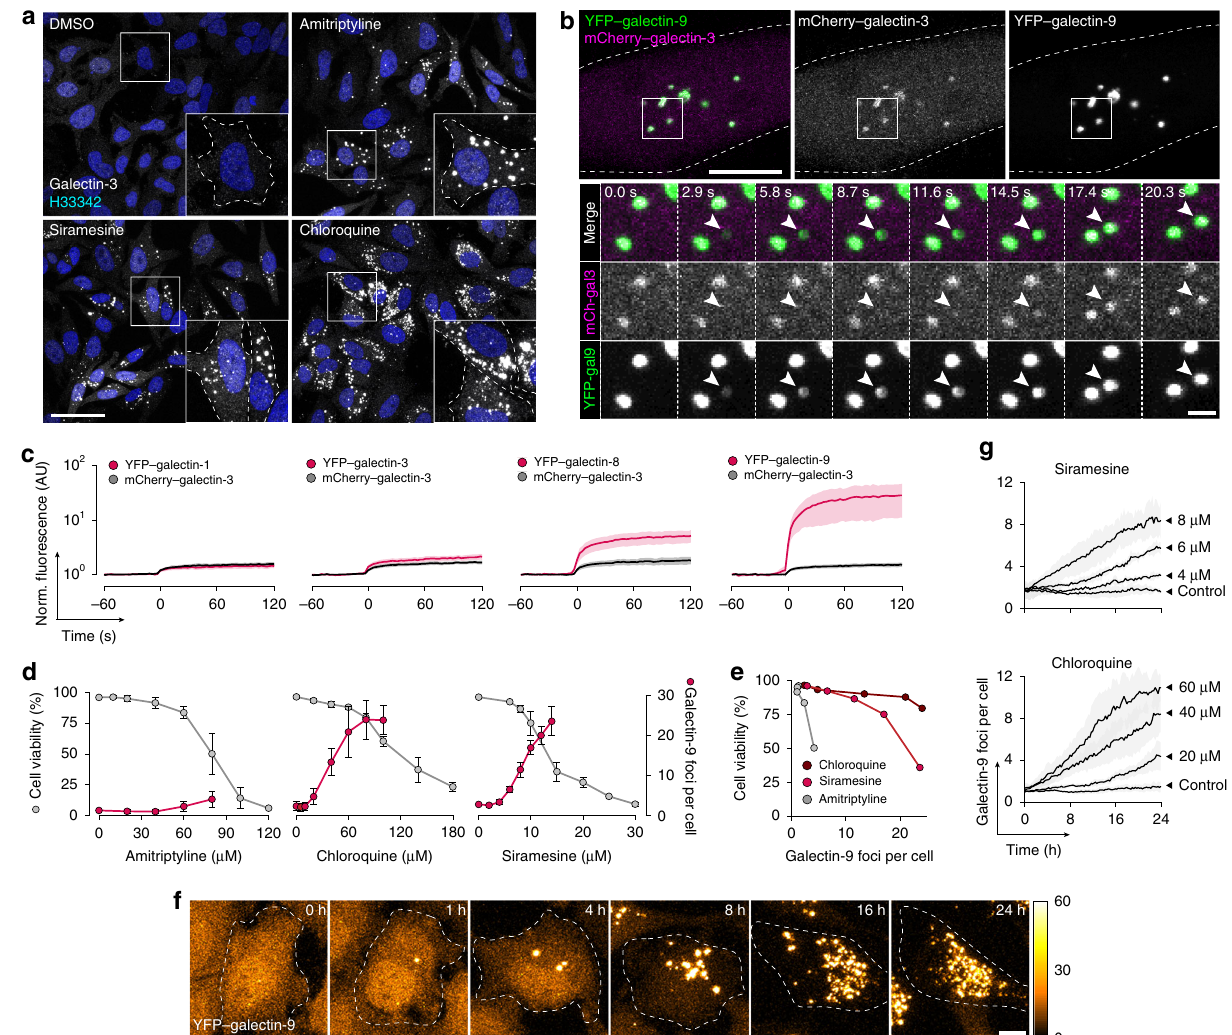
Fig. 1 Galectin-9 is a reliable sensor of drug-induced membrane perturbation in live cells. a Confocal microscopy images of HeLa cells stained for galectin-3 after treatment with 10 μ M siramesine, 50 μ M amitriptyline, or 50 μ M chloroquine for 24 h. Images are representative of two independent experiments. Scale bar, 50 μ m. b HeLa cells co-expressing mCherry – galectin-3 and YFP – galectin-9 were imaged with confocal microscopy during treatment with 10 μ M siramesine. Image subset shows de novo galectin recruitment. Images are representative of four independent experiments. Scale bar, 10 μ m; detail 2 μ m. c Quanti fi cation of galectin recruitment from confocal microscopy images of HeLa cells expressing the indicated galectin pairs, treated with 10 μ M siramesine. Line is mean, shade is 95% CI. Traces are aligned so that galectin recruitment is fi rst detected at t = 0. N = 52, 54, 45, and 54 events from at least two independent experiments. d Cell viability after 24 h drug treatment was determined by propidium iodide staining and fl ow cytometry. The number of galectin-9 foci per cell was quanti fi ed from confocal microscopy images after 24 h drug treatment. Mean± s.d. from